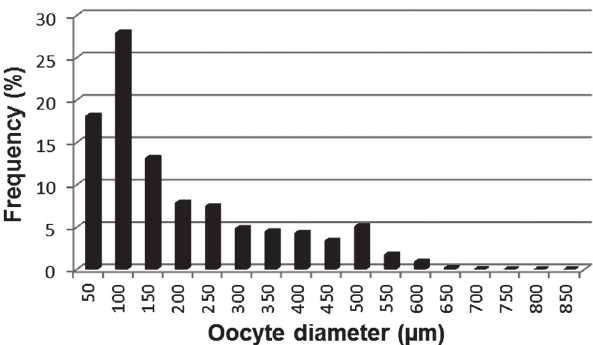
Fig. 5. Oocyte diameter distribution in spawning capable phase of Anchoa marinii . N=